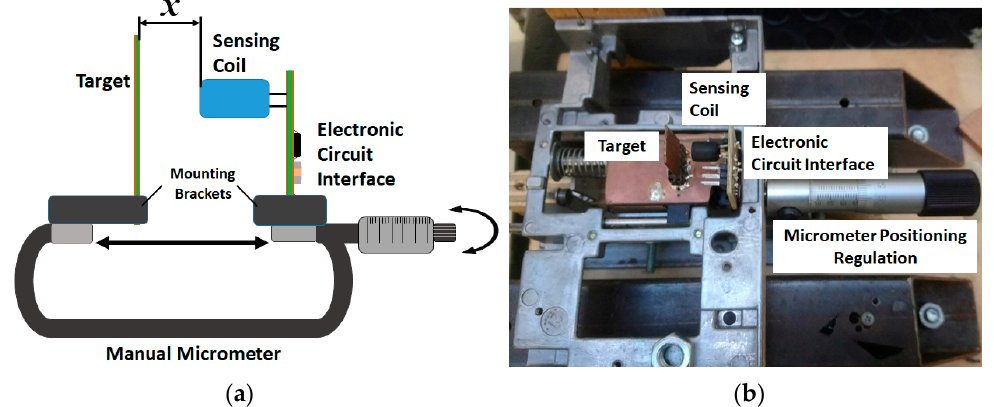
Figure 4. Measurement setup. Simplified sketch ( a ) and real setup ( b ). By rotating the micrometer’s knob, it is possible to change the distance between the sensing coil and target in a controlled and repeatable